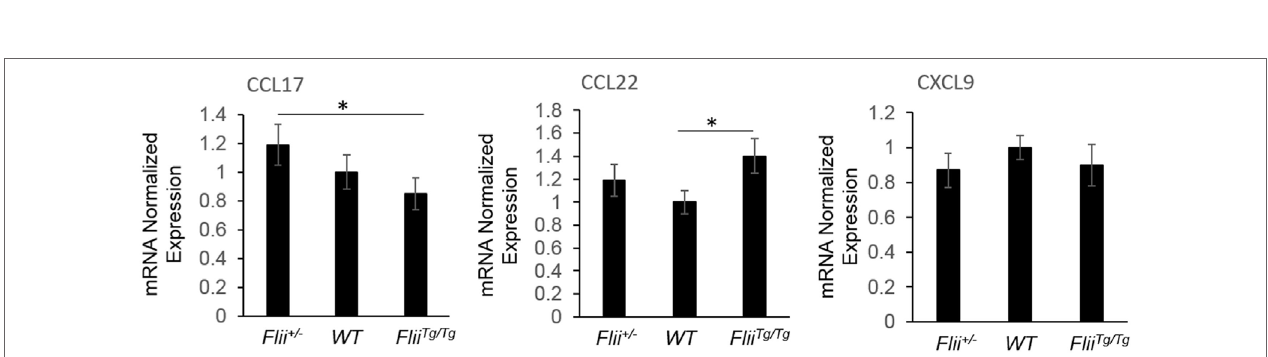
FigUre 4 | Flii expression affects Th 2 chemokine levels in OVA-induced atopic dermatitis (AD) skin-like lesions. mRNA levels of CCL17, CCL22, and CXCL9 chemokines responsible for manifestation of AD were analyzed in the OVA-induced AD skin-like lesions of Flii + / − , wild-type, and Flii Tg/Tg animals. OVA-induced AD skin-like lesions of Flii + / − mice have significantly higher levels of CCL17 compared to Flii Tg/Tg counterparts, while CCL22 was significantly increased in OVA-induced AD skin-like lesions of Flii Tg/Tg mice compared to wild-type controls. n = 6. Mean ± SEM. * < 0.05.